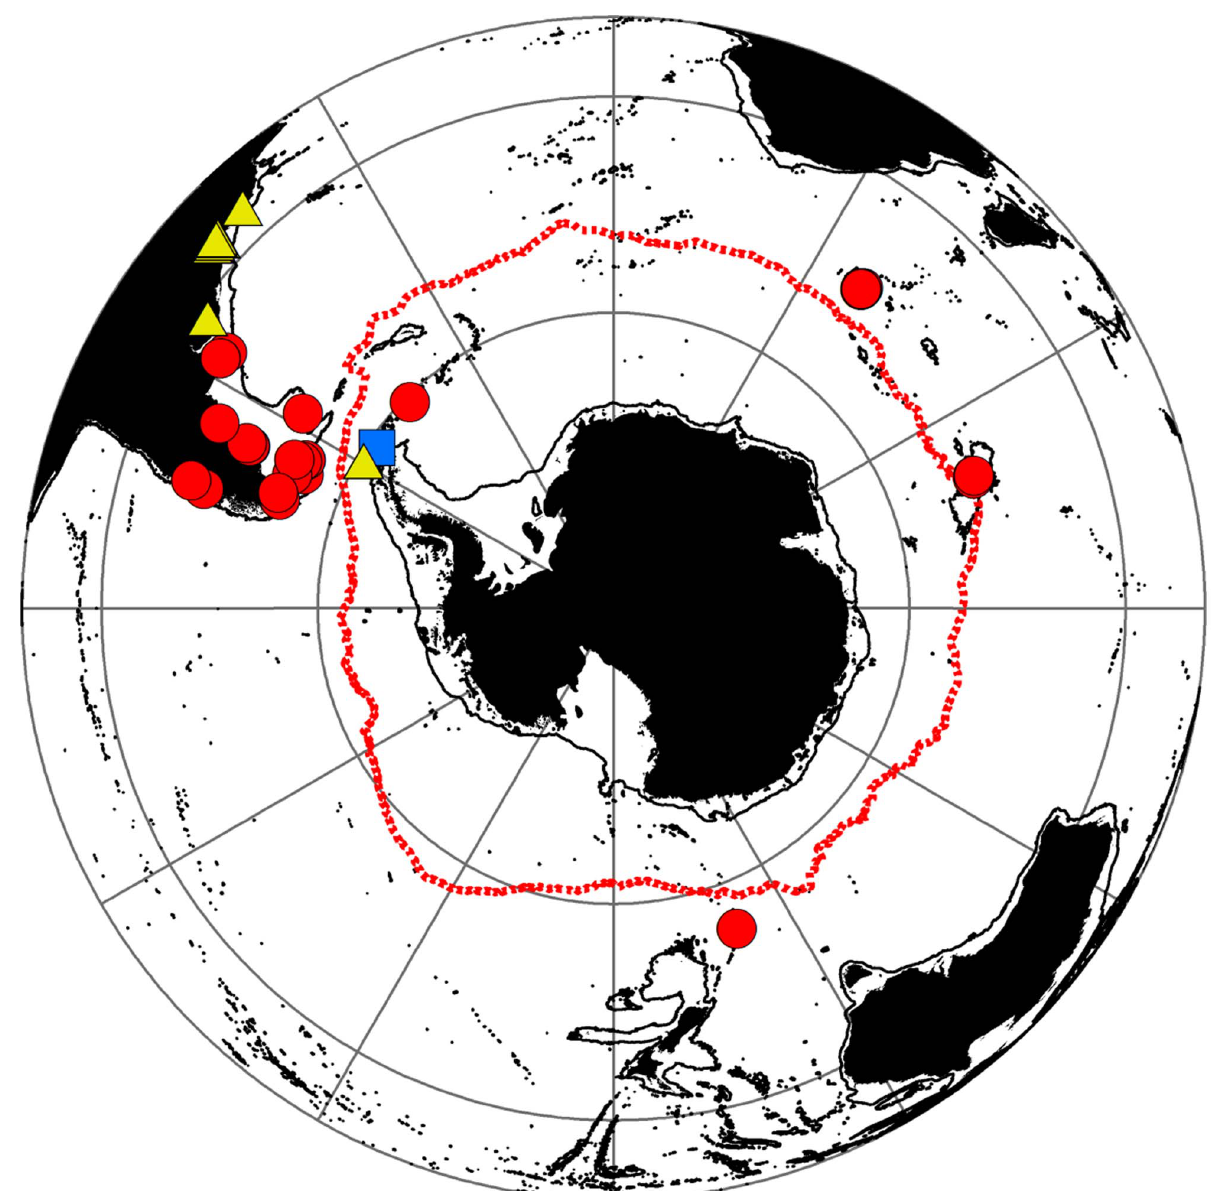
Figure 4. Distribution of brachyuran crabs found south of 60 u S. Red circle= Halicarcinus planatus =, Blue square= Hyas araneus and Yellow triangle= Rochinia gracilipes . Red line=Mean position of Polar Front (Moore et al.,